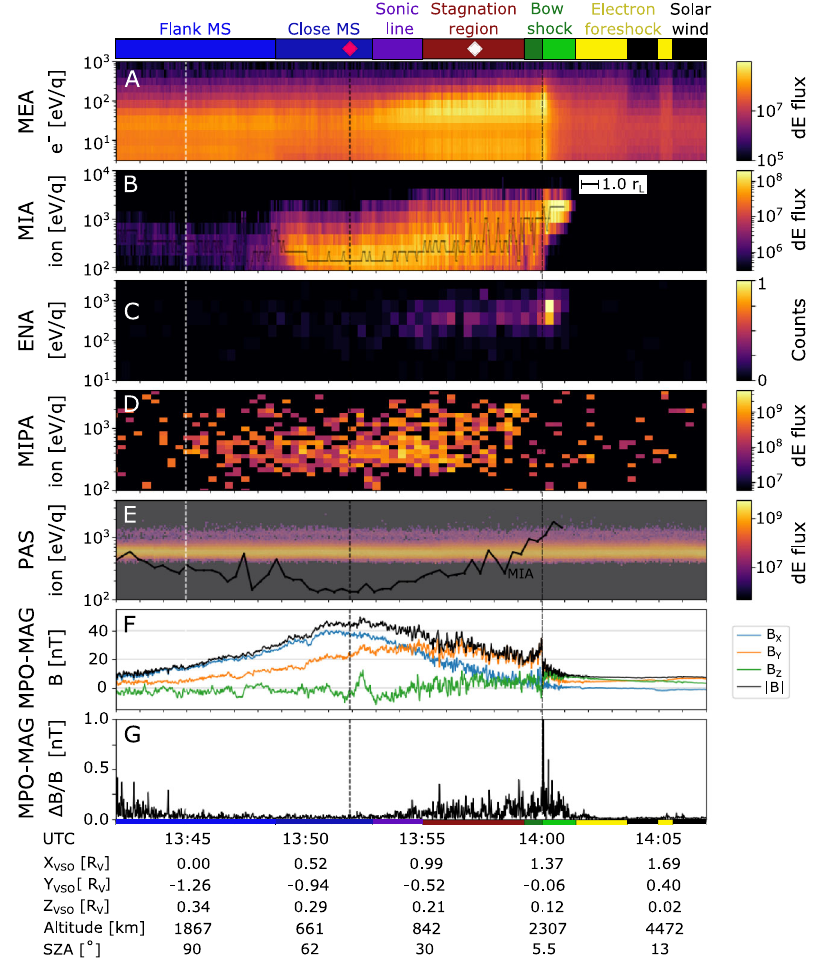
Fig. 3 | Electron, ion and magnetic fi eld measurements made by the three spacecraft MPO, Mio, and Solar Orbiter during BepiColombo ’ s 2 nd Venus fl yby on August 10, 2021. Energy-time spectrogram of omni-directional ( A ) Mio/MPPE/ MEA differential energy fl ux (dE fl ux) [cm − 2 s − 1 eV/eV] 37,47 , ( B ) Mio/MPPE/MIA dif- ferentialenergy fl ux[cm − 2 s − 1 eV/eV] 37 (withblacklineshowingthepeakenergybin), ( C ) Mio/MPPE/ENA normalized counts 37 , which nominally measures energetic neutral atoms but here measures neutrals originating from protons neutralized by the interaction with the spacecraft structures and thus operates as a very sensitive monitor of proton fl uxes, ( D ) MPO/SERENA/MIPA differential energy fl ux [cm − 2 s − 1 eV/eV] 49 , ( E ) Solar Orbiter/PAS differential energy fl ux [cm − 2 s − 1 eV/eV] 18 (shifted by 1h, and slightly shaded) with the peak energy bin from MIA (black line, smoothed for clarity) overplotted for comparison, ( F ) the magnetic fi eld measured by MPO- MAG 50 inVSOcoordinates,and( G )thevariationsofthemagnetic fi eldmeasuredby MPO-MAG. All ion measurements are shown integrated over mass. The terminator